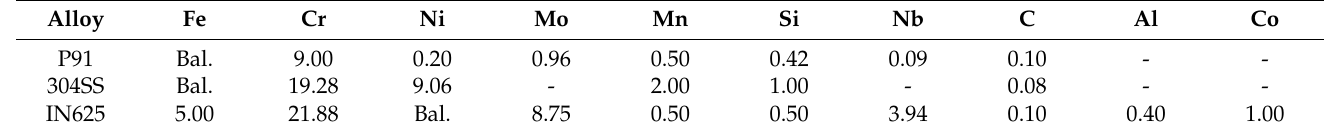
Table 2. Chemical composition (in wt.%) of as-received P91, 304SS, and IN625 alloys. Alloy Fe Cr